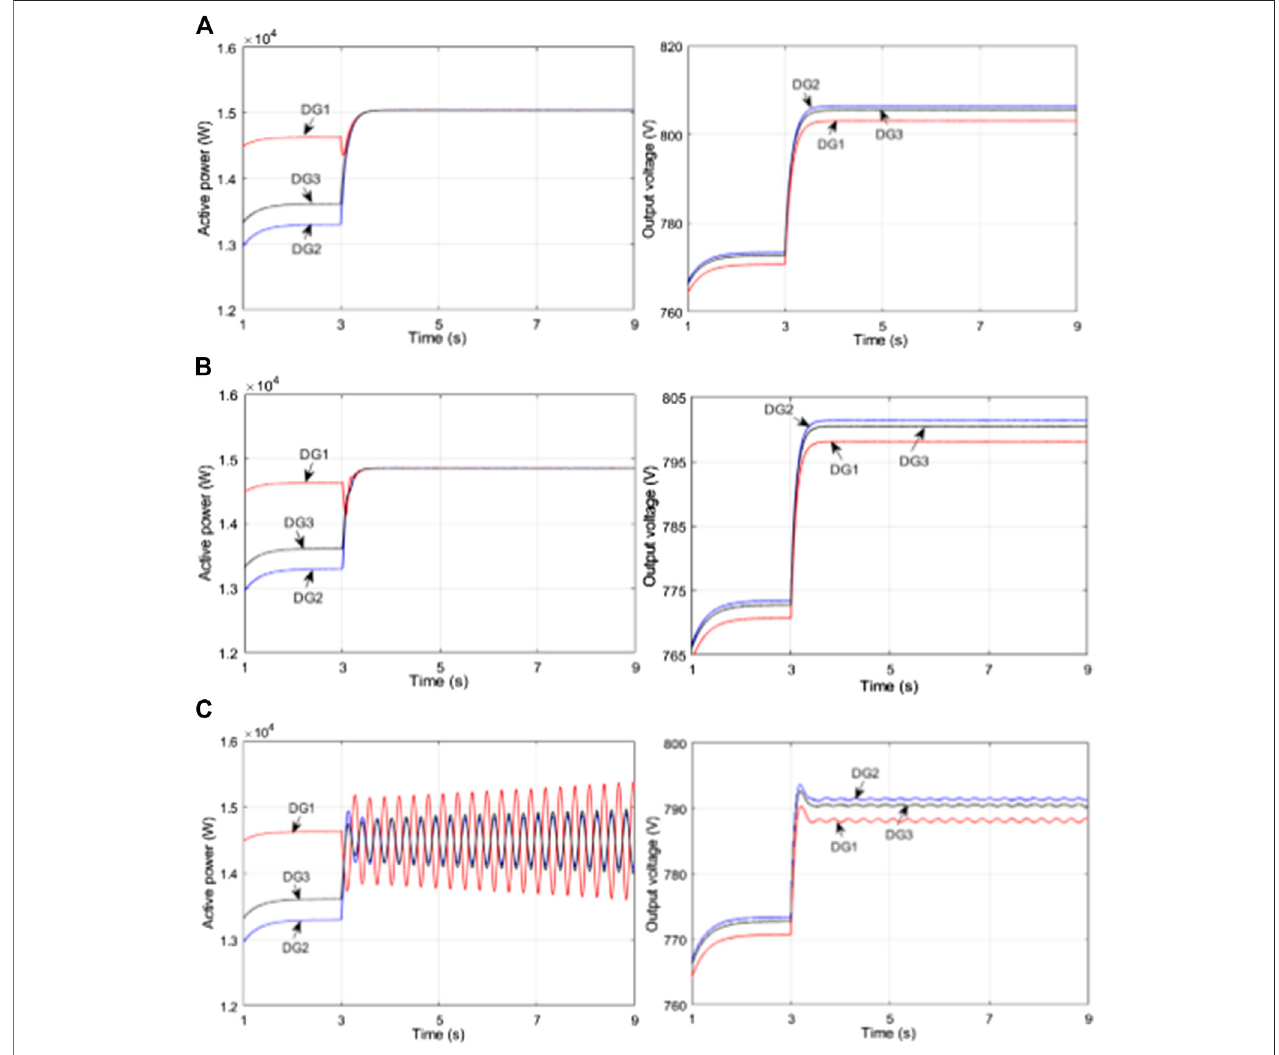
FIGURE 6 | Simulation results of active powers and actual output voltages with various input delays and a fi xed communication delay of τ ij (cid:1) 30 ms (A) τ (cid:1) 0 ms (B) τ (cid:1) 30 ms (C) τ (cid:1) 60 ms.